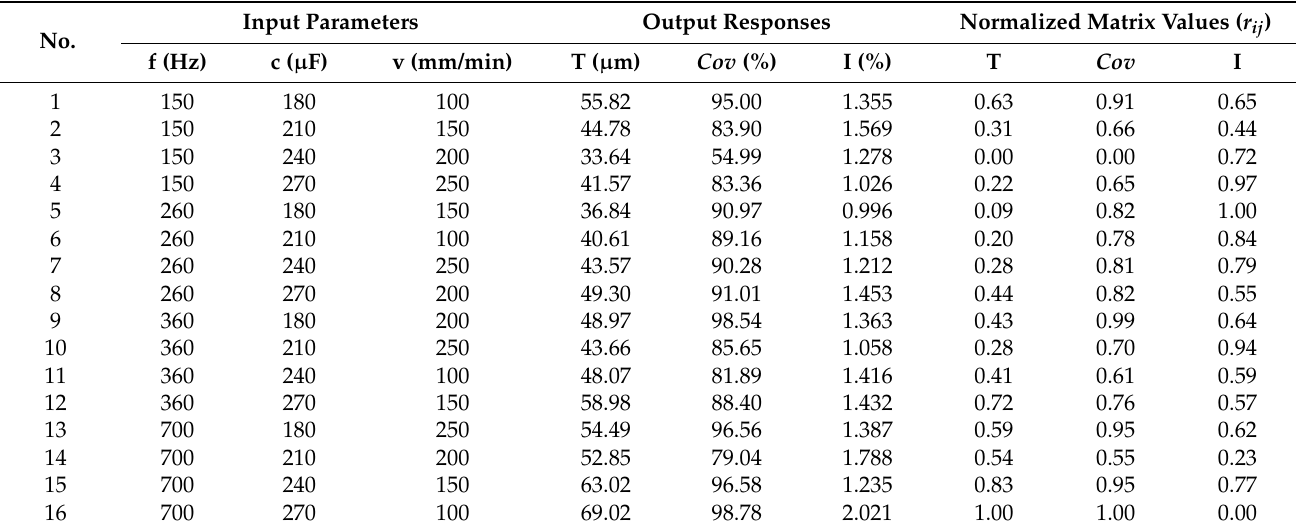
Table 2. Orthogonal test design and response calculation results.